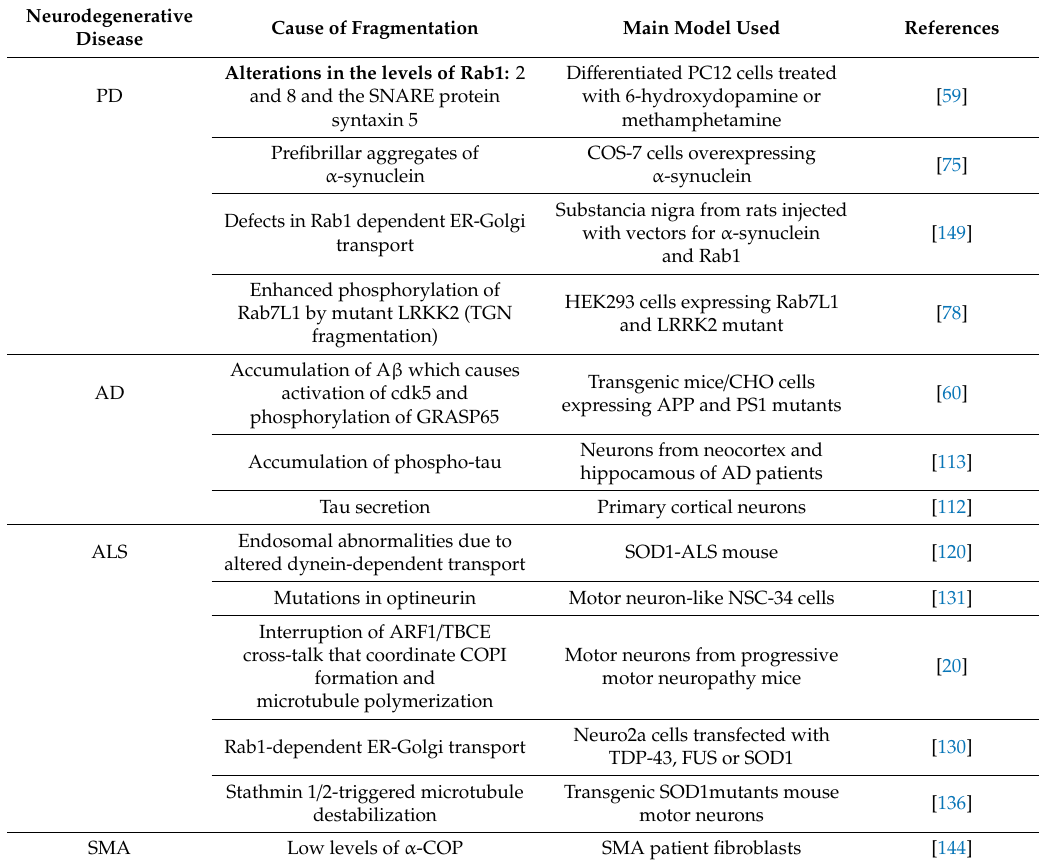
Table 1. Summary of the putative causes of Golgi fragmentation in neurodegenerative diseases (see text for